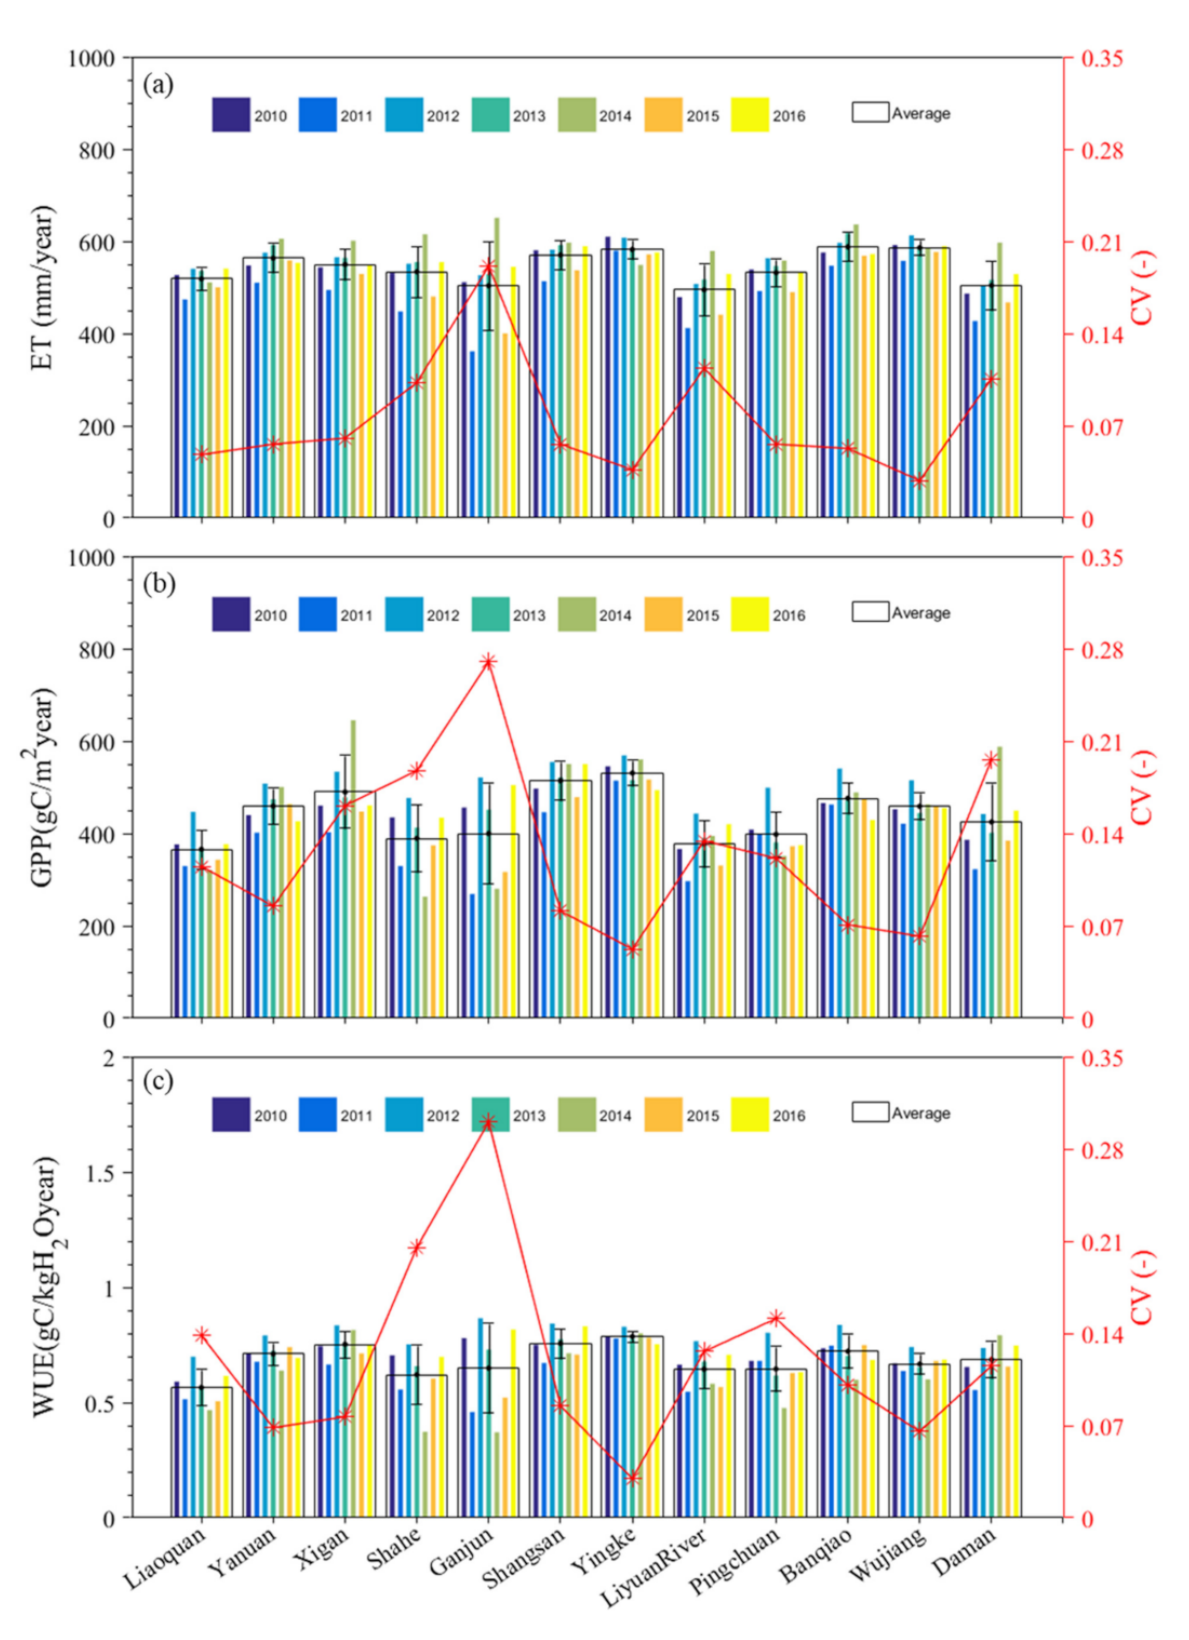
Figure 7. Comparison of multi-year ( a ) ET, ( b ) GPP, and ( c ) WUE for 12 irrigation districts over seven-year study period (2010–2016) for midstream